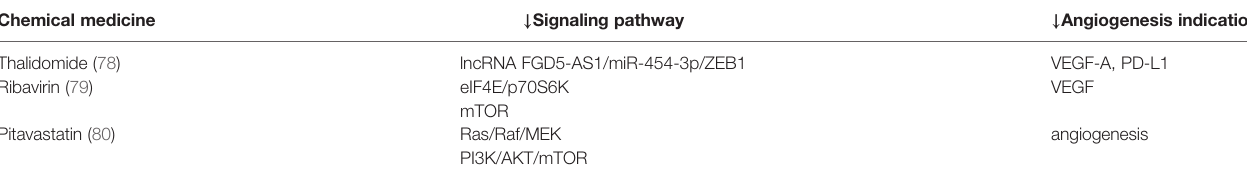
TABLE 4 | Research progress of existing chemical medicine in angiogenesis in lung cancer. Chemical medicine ↓ Signaling pathway